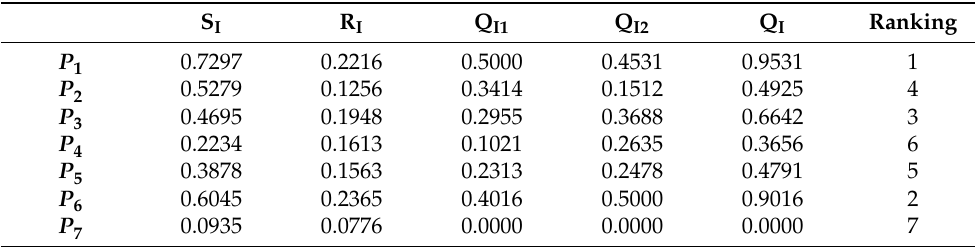
Table 9. Utility values, individual regret values, and